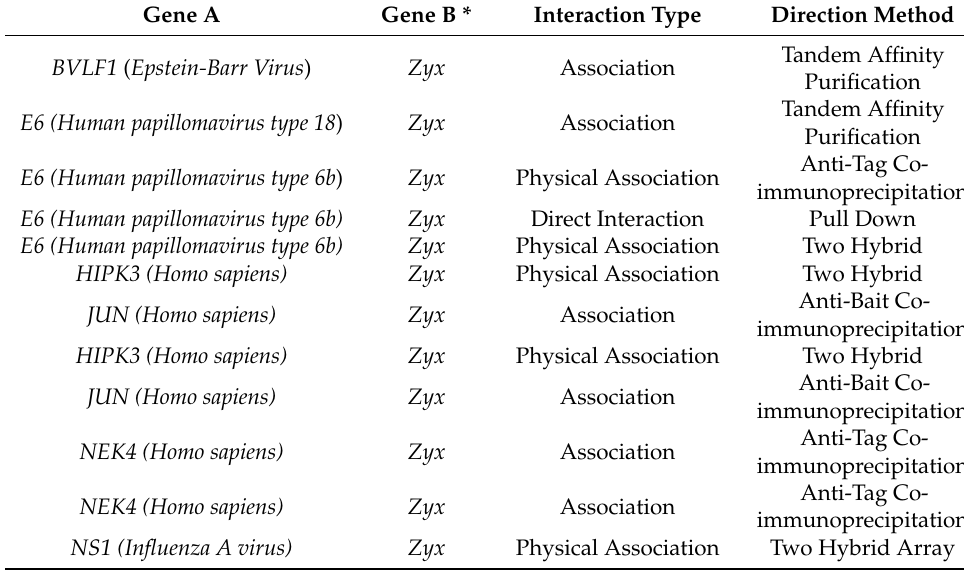
Table 6. MINT analysis of Zyxin protein. Gene A Gene B * Interaction